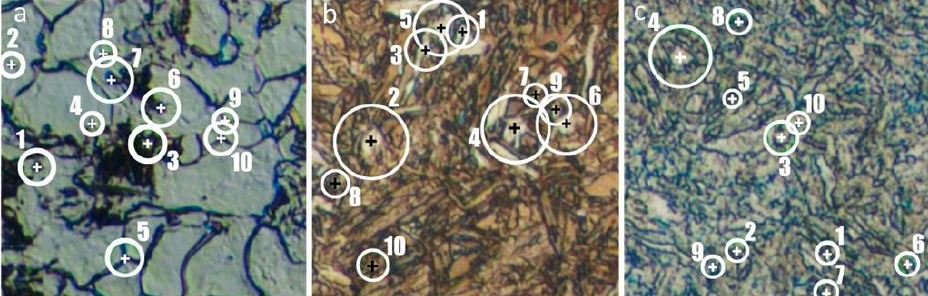
Figure 4. A selection of the 10 strongest keypoints in steel samples annealing ( a ), quenching ( b ) and tempering ( c ). 1 is the strongest keypoint and 10 the weakest. Table 3. Accuracy (%) in classic ML models.